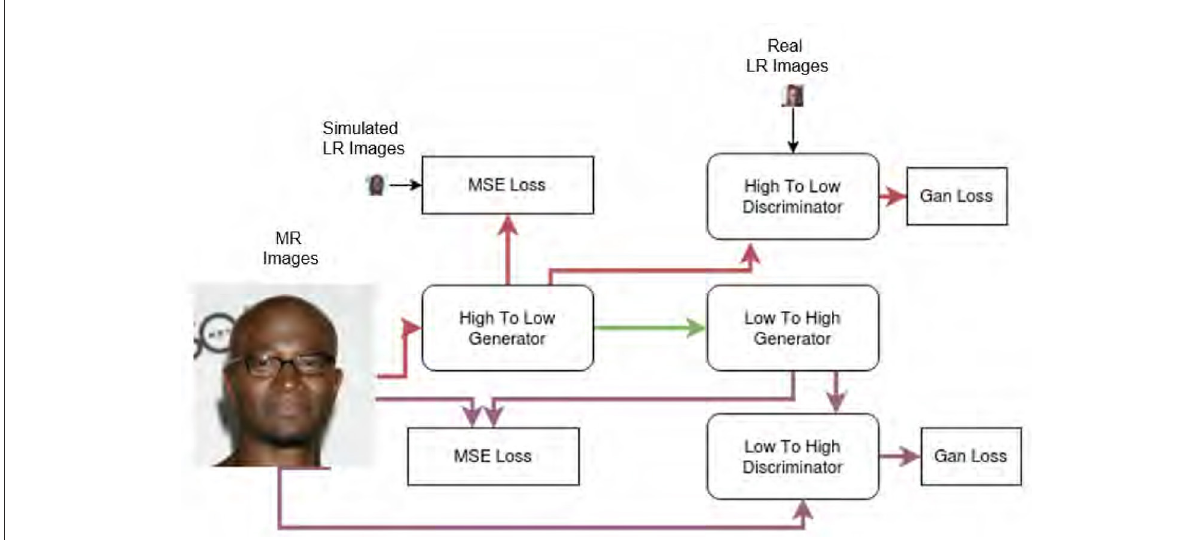
FIGURE4 Overview of the CycleGan (Liu et al., 2021b) based architecture of step 1 of our method. Details of all components are presented in Section